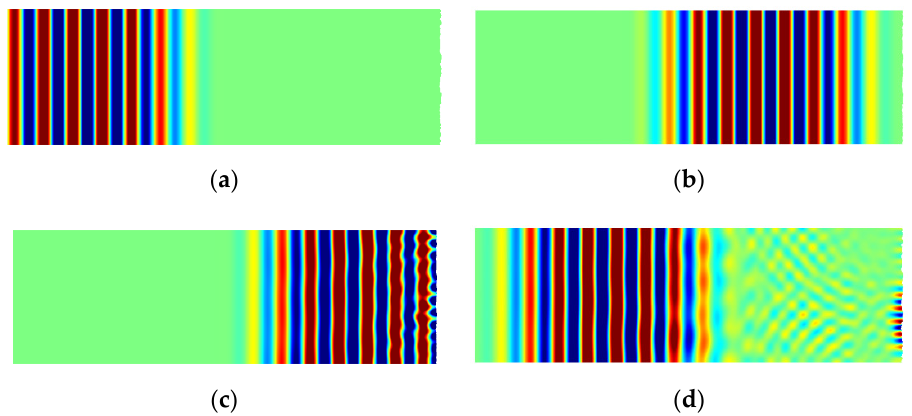
Figure 5. Snap shots at different times of wave propagation in the FE simulation: ( a ) 𝑡 = 1.5 μs ; ( b ) 𝑡 = 3 μs ; ( c ) 𝑡 = 4.5 μs ; ( d ) 𝑡 = 6 μs .